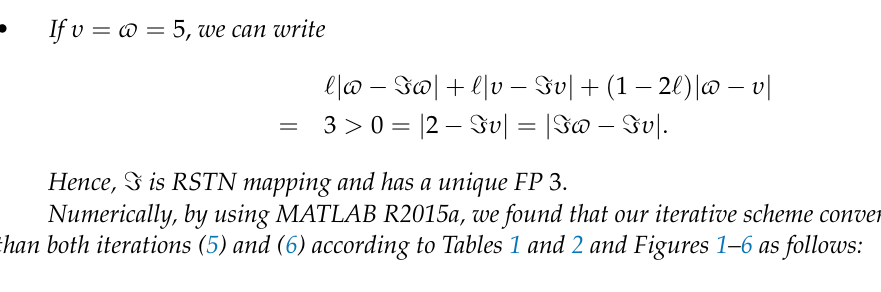
Table 1. Numerical comparison of results of Algorithms (5)–(7).